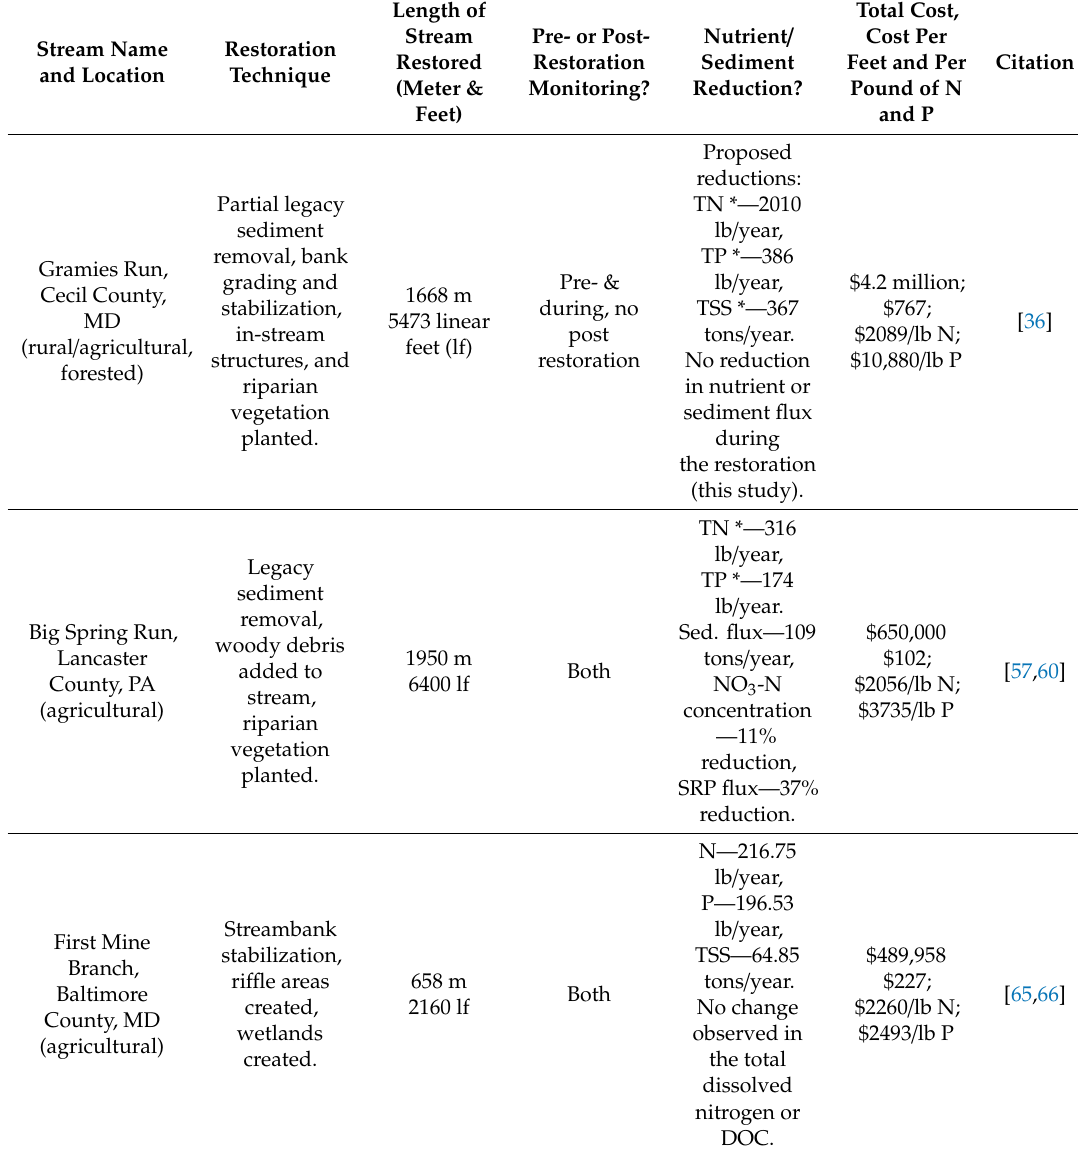
Table 3. Comparisons of various stream restorations for costs, restoration techniques, and nutrient and sediment